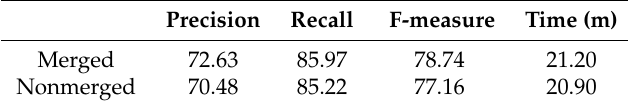
Table 1. Effect of merging blob lines.